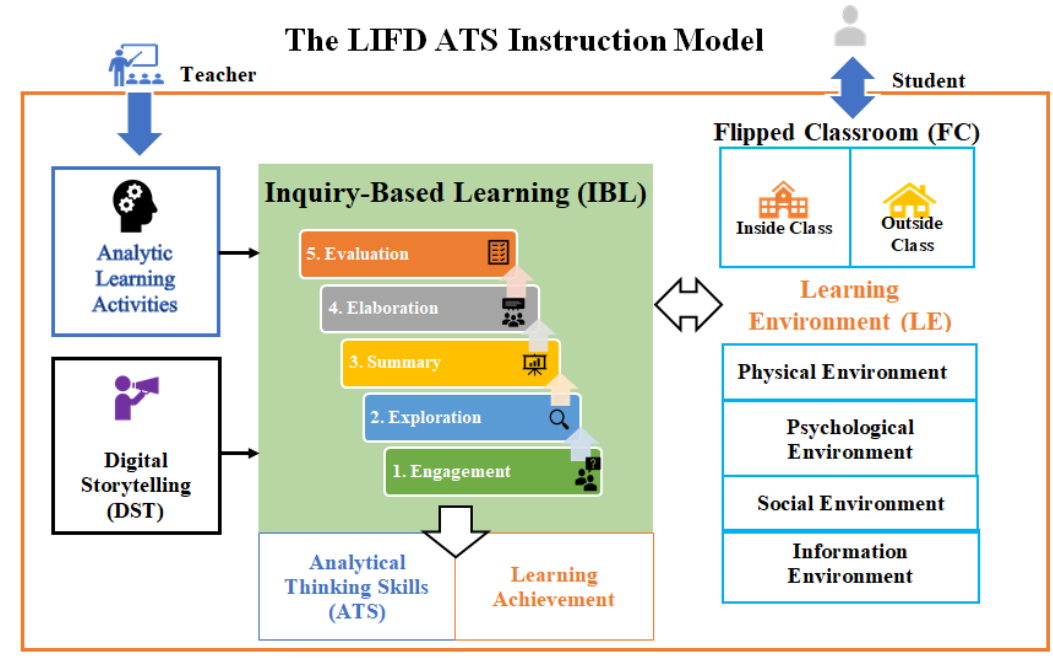
Figure 2. The final LIFD ATS Instruction